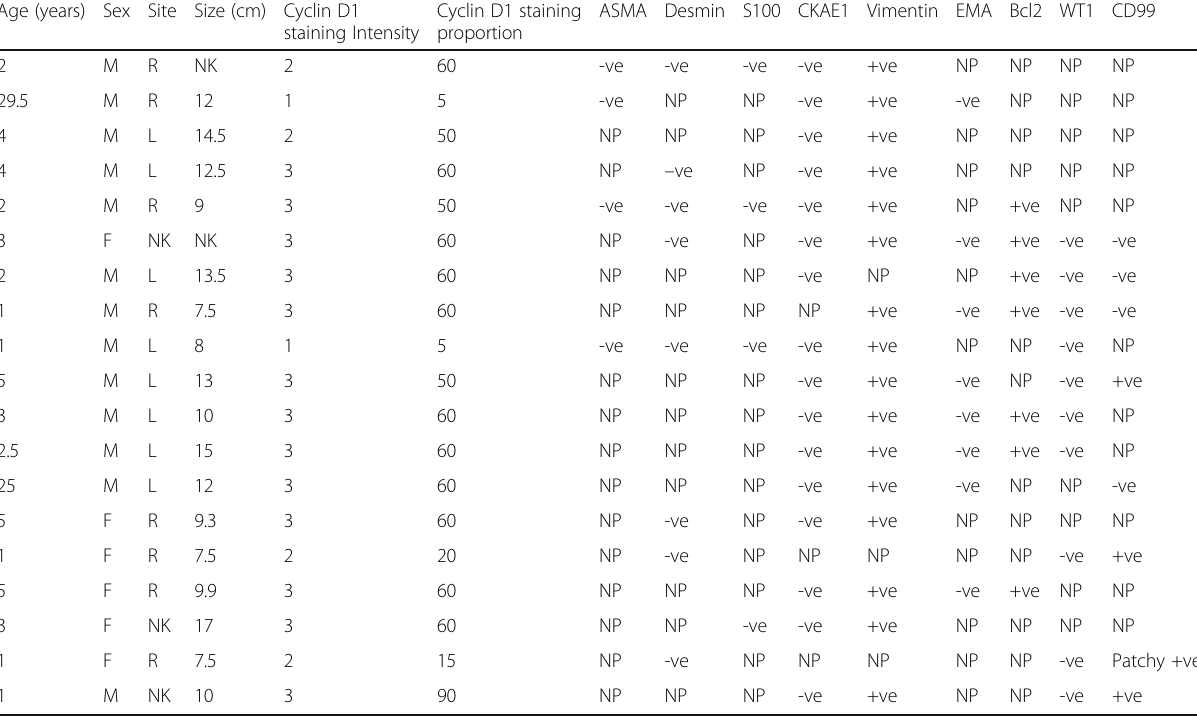
Table 1 Clinical details and results of immunohistochemical staining with Cyclin D1 and other IHC markers in clear cell sarcoma of kidney ( n = 19)